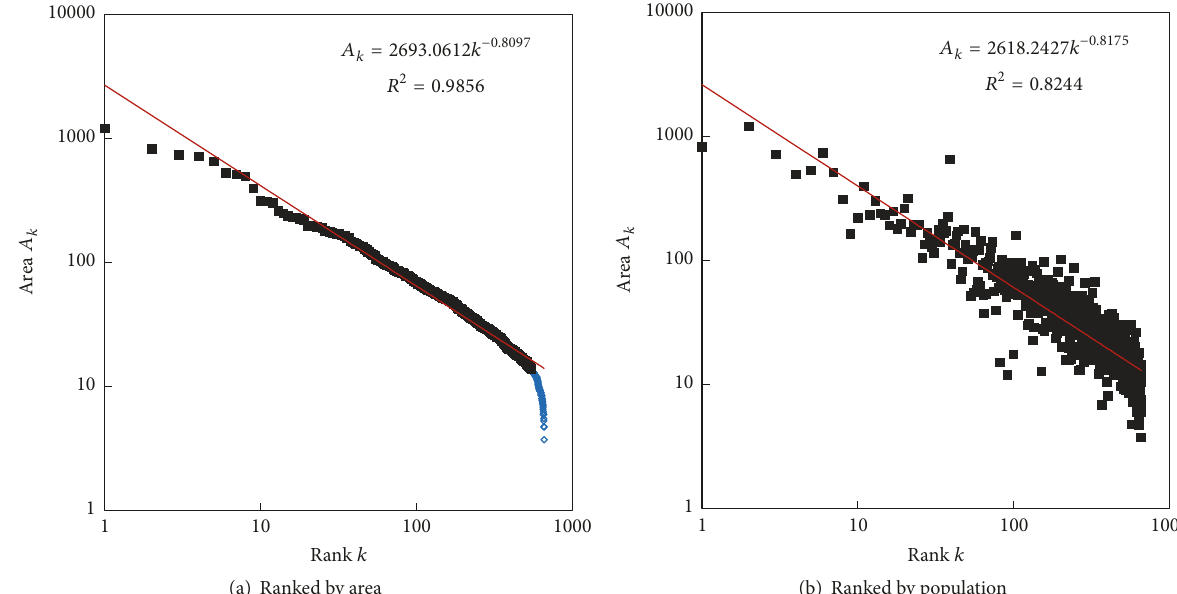
Figure 10: The rank-area distributions of Chinese cities based on built-up area and population size in